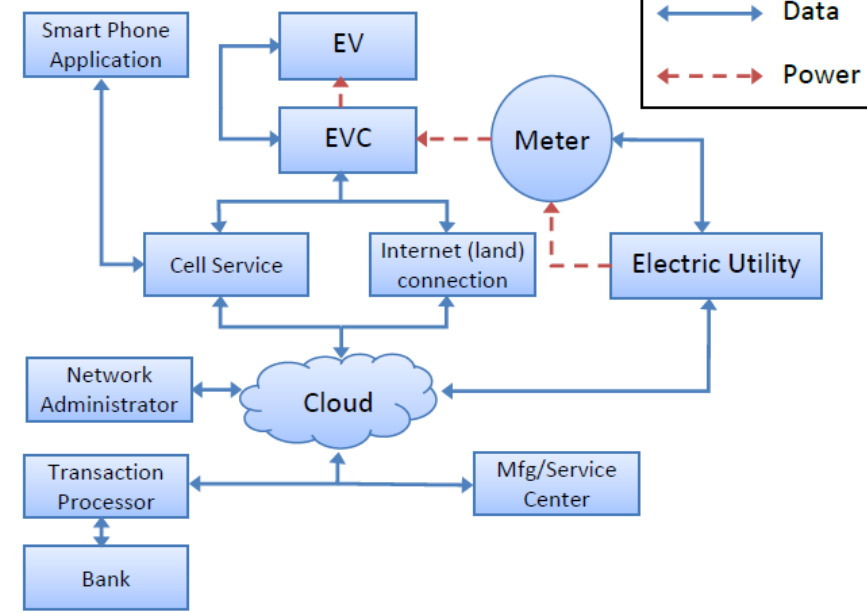
Figure 2. The subsystem for remote control of EV chargers.